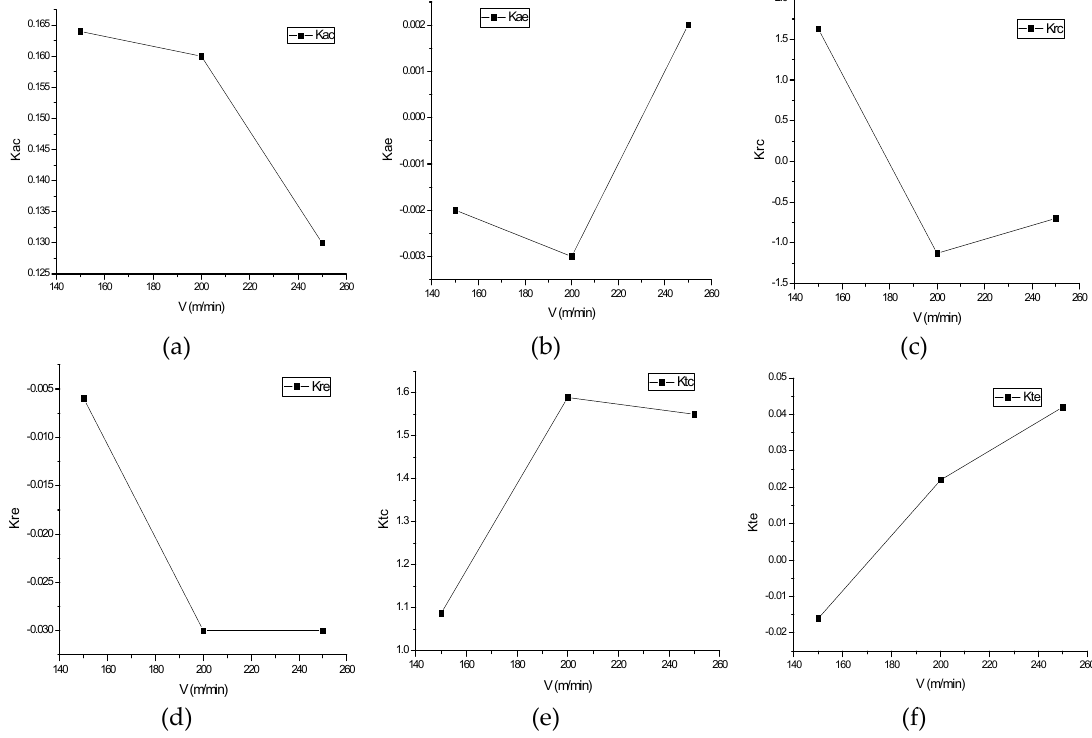
Figure 6. The trend of decomposition stress. ( a ) The parameter K ac varies with the cutting speed; ( b ) The parameter K ae varies with the cutting speed; ( c ) The parameter K rc varies with the cutting speed; ( d ) The parameter K re varies with the cutting speed; ( e ) The parameter K tc varies with the cutting speed; ( f ) The parameter K te varies with the cutting speed.